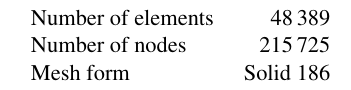
Figure 18. Frame (with/without stiffeners) – restrained end.